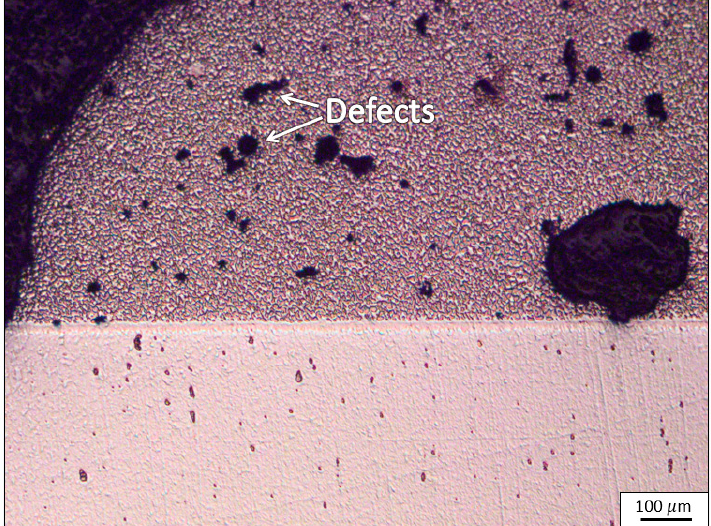
Figure 2. Optical micrograph showing microstructure of specimen S1 (950 °C for 10 min) with numerous defects. numerous